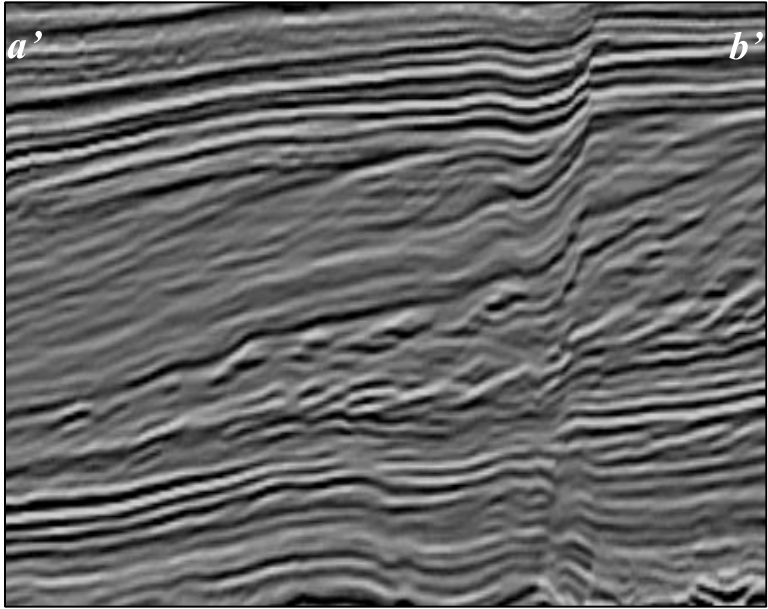
Figure 16. Cross-section of a major normal fault observed in the F3 block which is representing profile a’b’ drawn in Figure 15A.